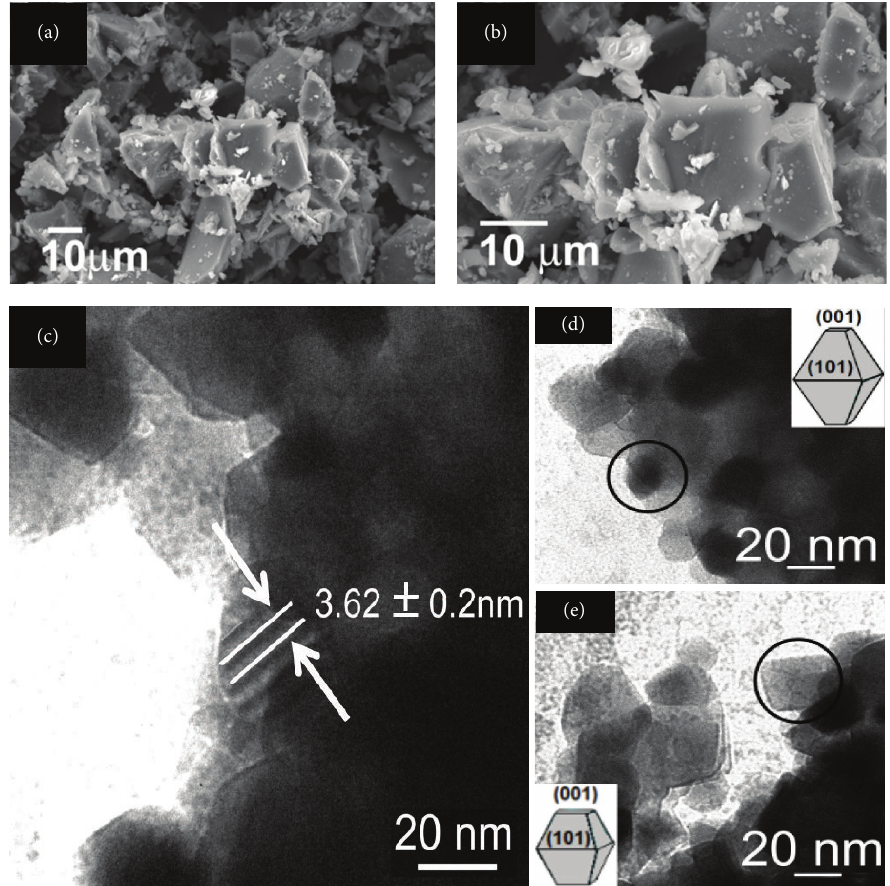
Figure 3: SEM and TEM images of the TiO 2 powder, magnified by (a) 1000x and (b) 2000x. (c) Morphology of the anatase (distance between marks is 3.8 nm). (d) 2D tetragons showing highly absorbing (001) facets and (e) images of TD synthetized in the absence of fluorine compounds. Insets of Figures (d) and (e) are representative sketches of the faceted